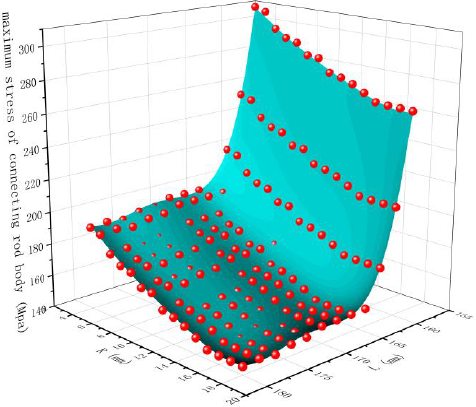
Figure 24. Corresponding graph of data points and formula surface after iteration.